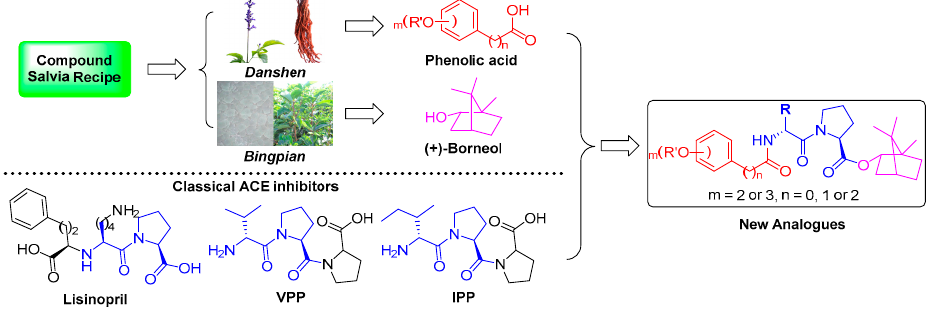
Figure 1. Structure design inspired by the formula of compound Salvia recipe and classical angiotensin converting enzyme (ACE) inhibitors. VPP: valine-proline-proline; IPP: isoleucine-proline-proline.